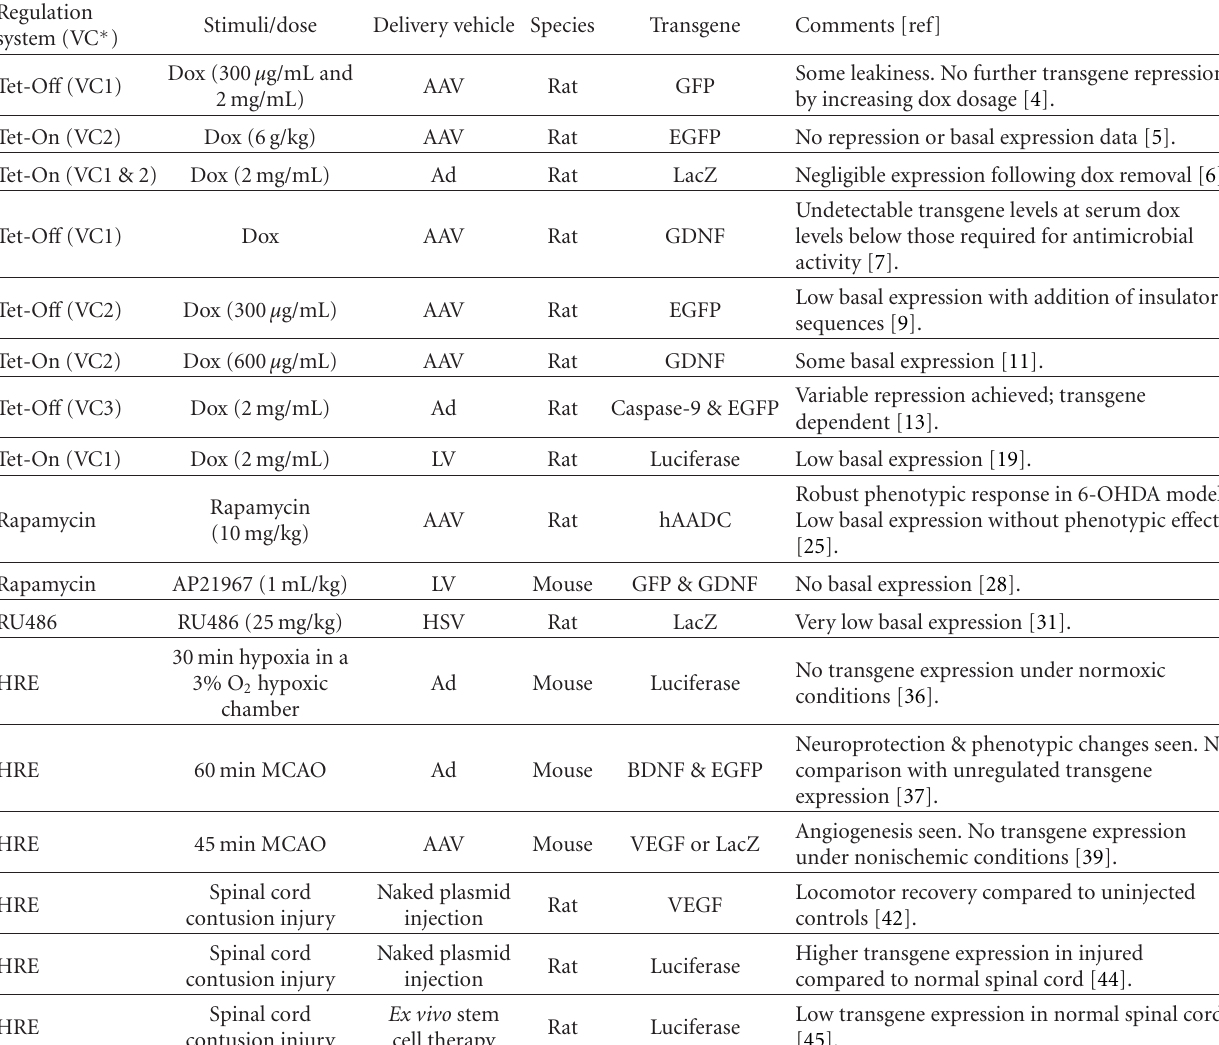
Table 1: Summary of use of gene regulation systems for in vivo CNS